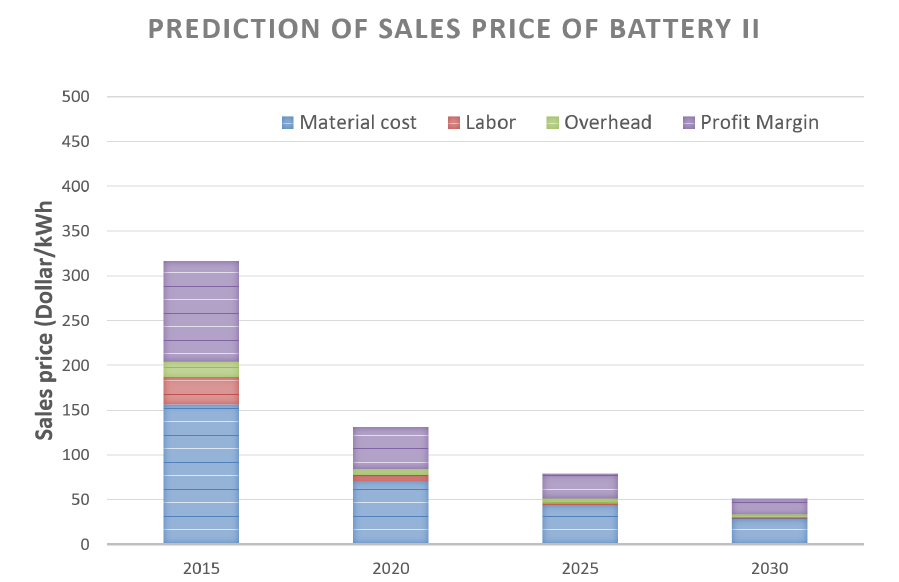
Figure 12. Prediction of sales price of battery II up to